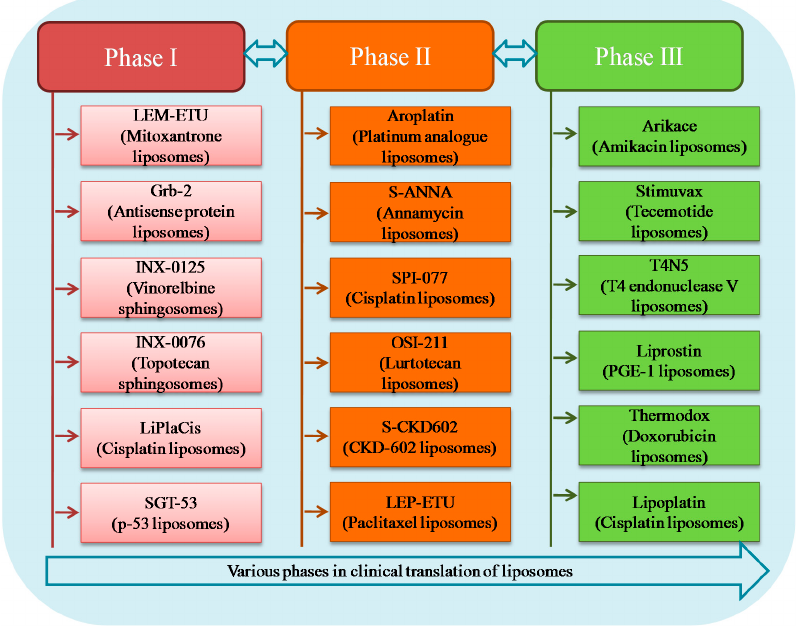
Figure 6. Liposomes present under different phases of clinical trial investigation.